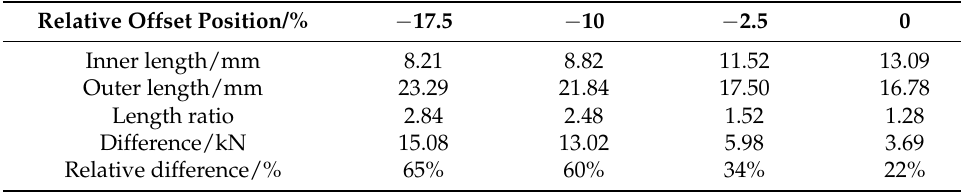
Figure 13. The influence of the rollers’ offset position on the tube deformation: ( a ) − 17.5%; ( b ) − 10%; ( c ) − 2.5%; ( d ) 0%. Table 2. The length of the contact line between the roller and the tube. Relative Offset